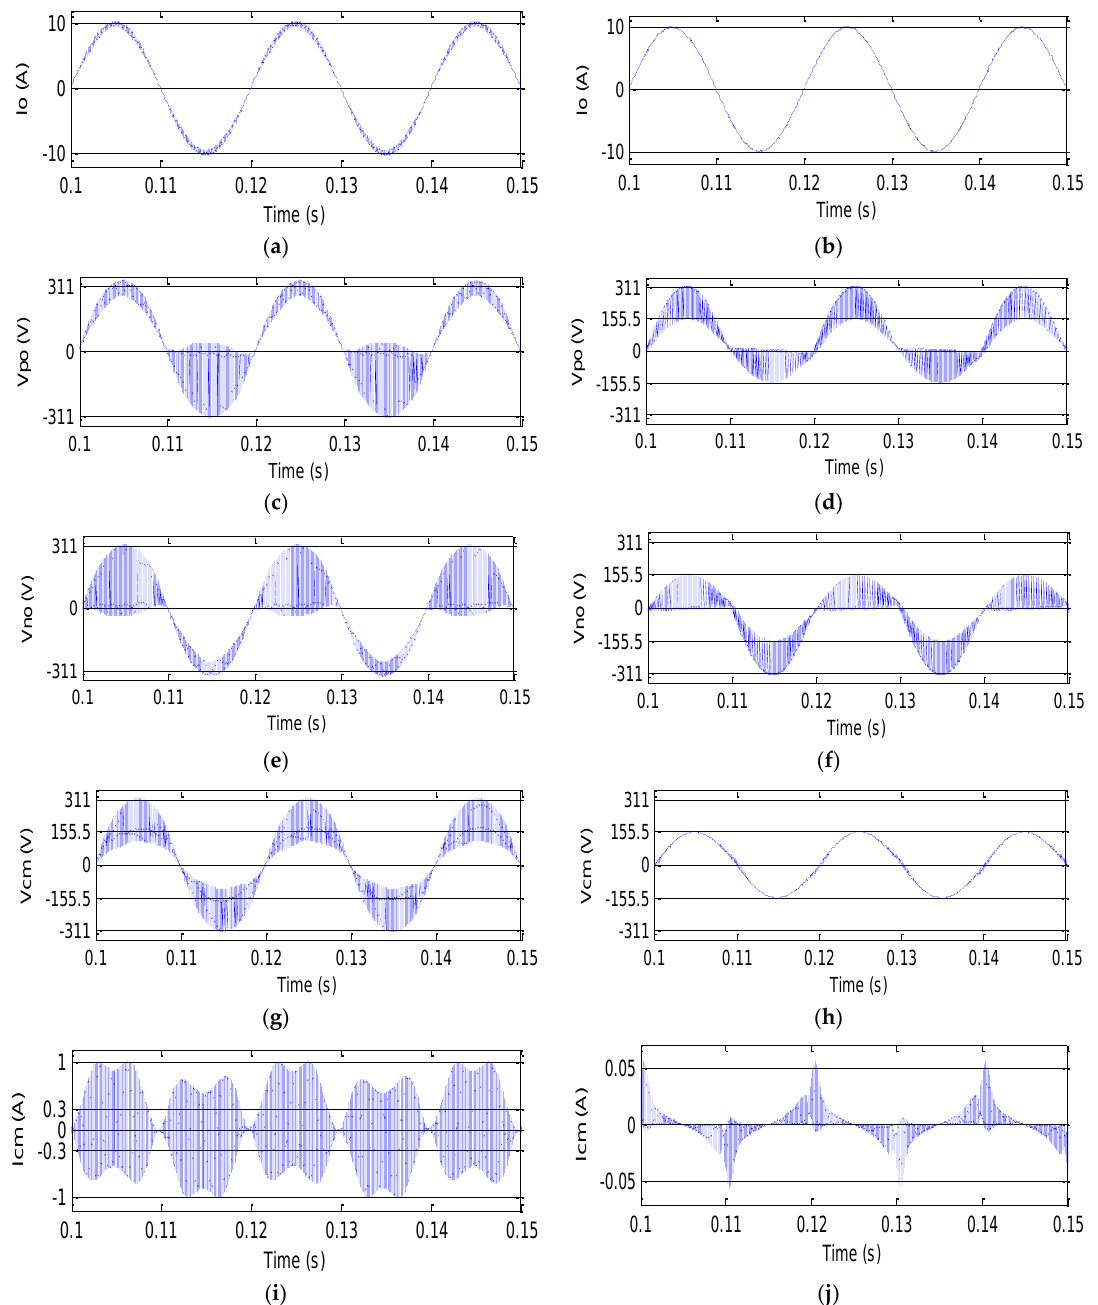
Figure 9. Simulation results of conventional CH4 inverter and proposed CH5 inverter. ( a ) Grid current of CH4; ( b ) Grid current of proposed one; ( c ) V po of CH4; ( d ) V po of proposed one; ( e ) V no of CH4; ( f ) V no of proposed one; ( g ) common-mode voltage (CMV) of CH4; ( h ) CMV of proposed one; ( i ) Leakage current of CH4; ( j ) Leakage current of proposed one.